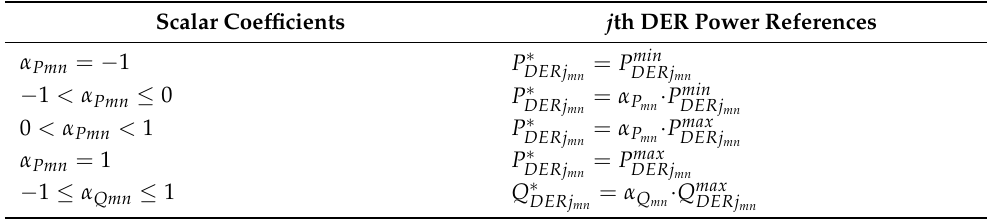
Table A1. Power references of the DERs implemented in each local controller.